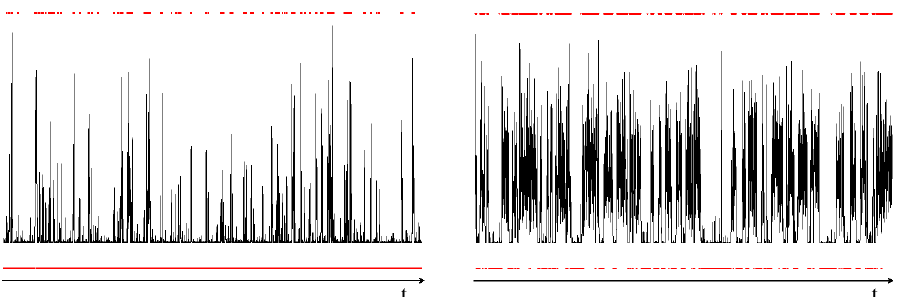
Figure 2. Schematic illustration of the evolution of the time intervals (red islands) in which the photon number exceeds a predetermined threshold for two different values of pump, computed from a Stochastic Laser Simulator [83] for β = 10 − 4 . The black lines represent the photon number. The pump in the two panels differs by about 2%. The relative time intervals are a c = 0.11 and a c = 0.57 for the left and right panels, respectively. a s = 1 − a c . Graphical resolution makes it almost impossible to detect the “holes” in the lower red set (left panel) which match the appearance of the red upper regions—they are, nonetheless, present. Data courtesy of G.P.